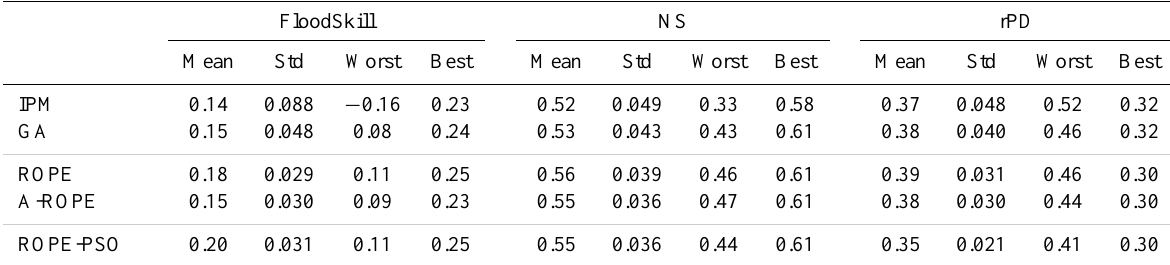
Table 7. Mean overall validation performance for the parameter vectors estimated by all compared algorithms; the model performance was calculated on the validation set as given in Table 5.